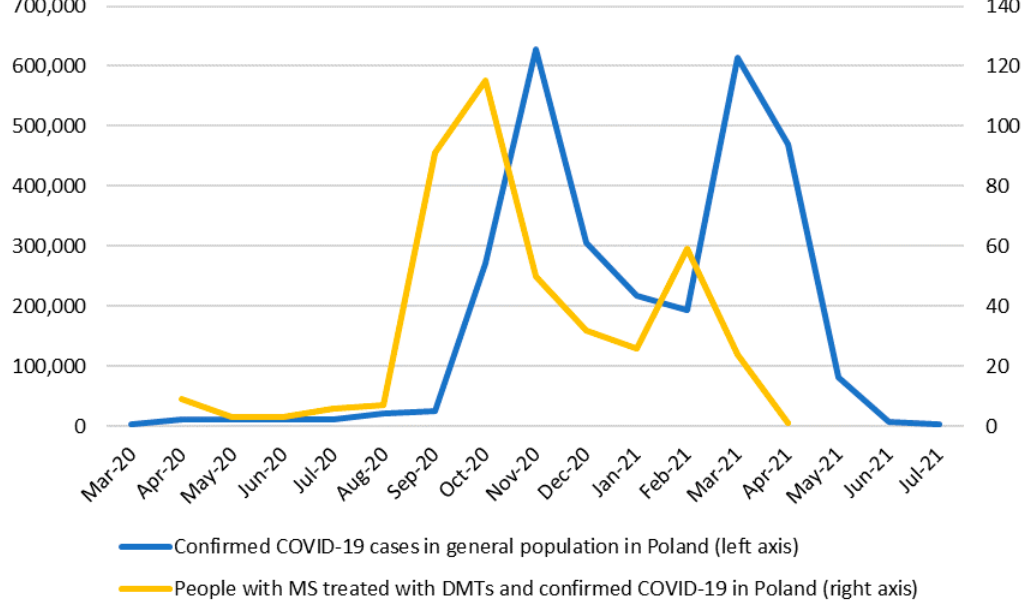
Figure 1. Confirmed cases of COVID-19: Individuals with MS versus general Polish population. Source: Ministry of Health, our own database of patients with MS, and our own calculations.